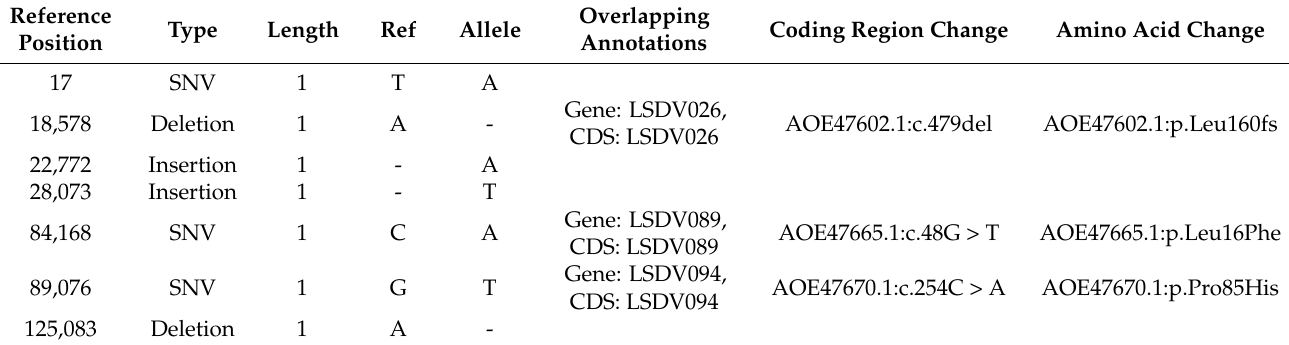
Table 2. SNPs (single-nucleotide polymorphisms) of KSGP O-240 refreshed on